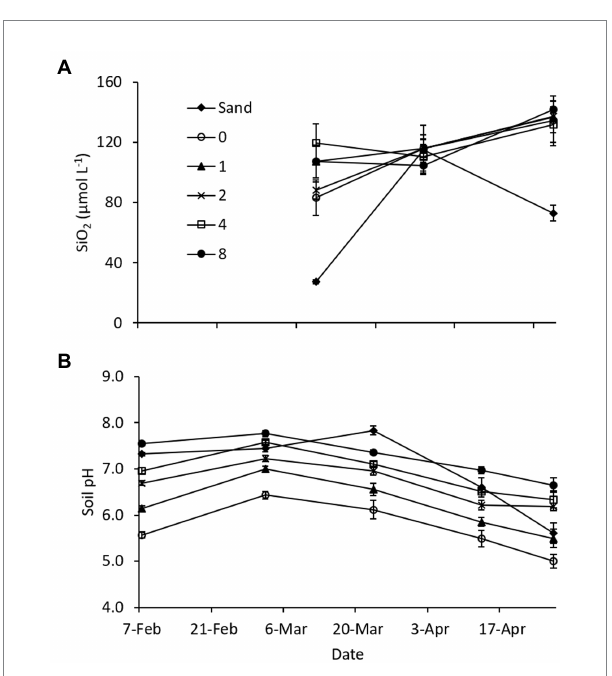
FIGURE 7 Mean (A) soil porewater dissolved Si (DSi) concentrations ( n = 5), and (B) soil pH ( n = 10) in the 2012 Si amendment laboratory (phytotron) experiment. Sand and 0 treatments received no soil amendment; other treatments received a calcium meta-silicate amendment at the rates indicated (Mg ha − 1 ). Error bars represent standard